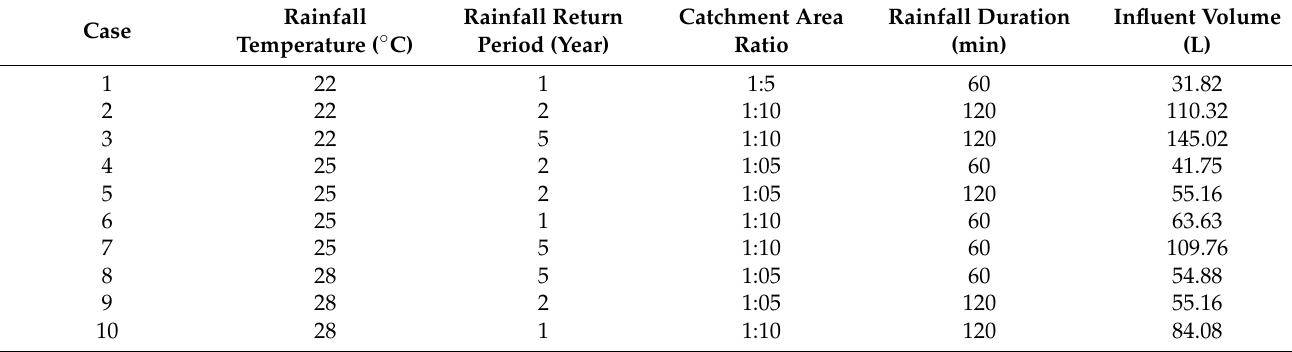
Table 1. Design of the experimental